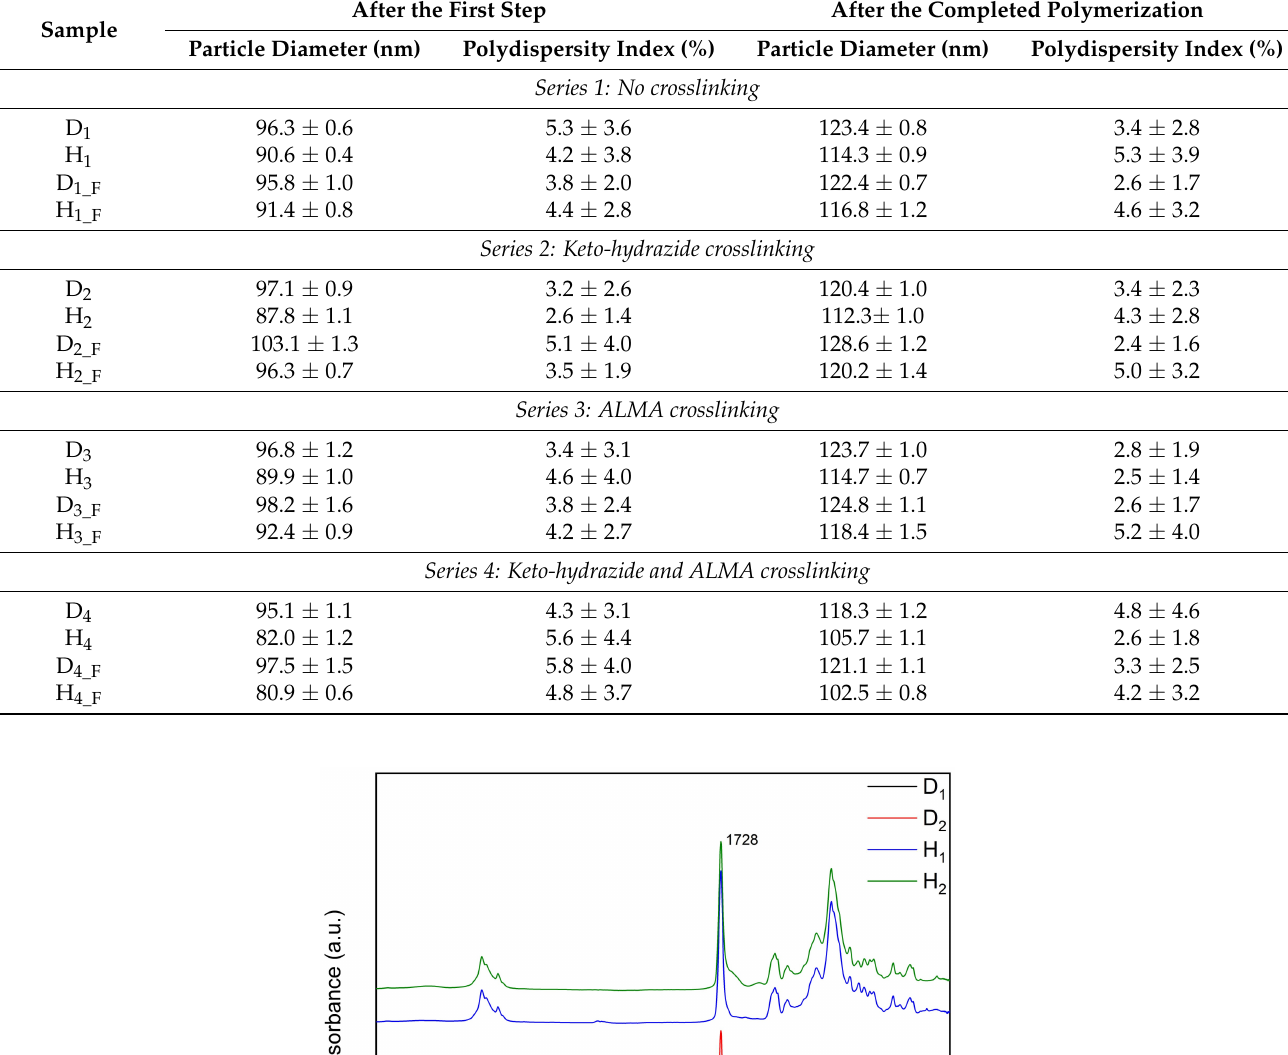
Table 4. DLS results for the prepared latexes differing in the fluorination of the second-step polymer, emulsifier type, and covalent crosslinking strategy.